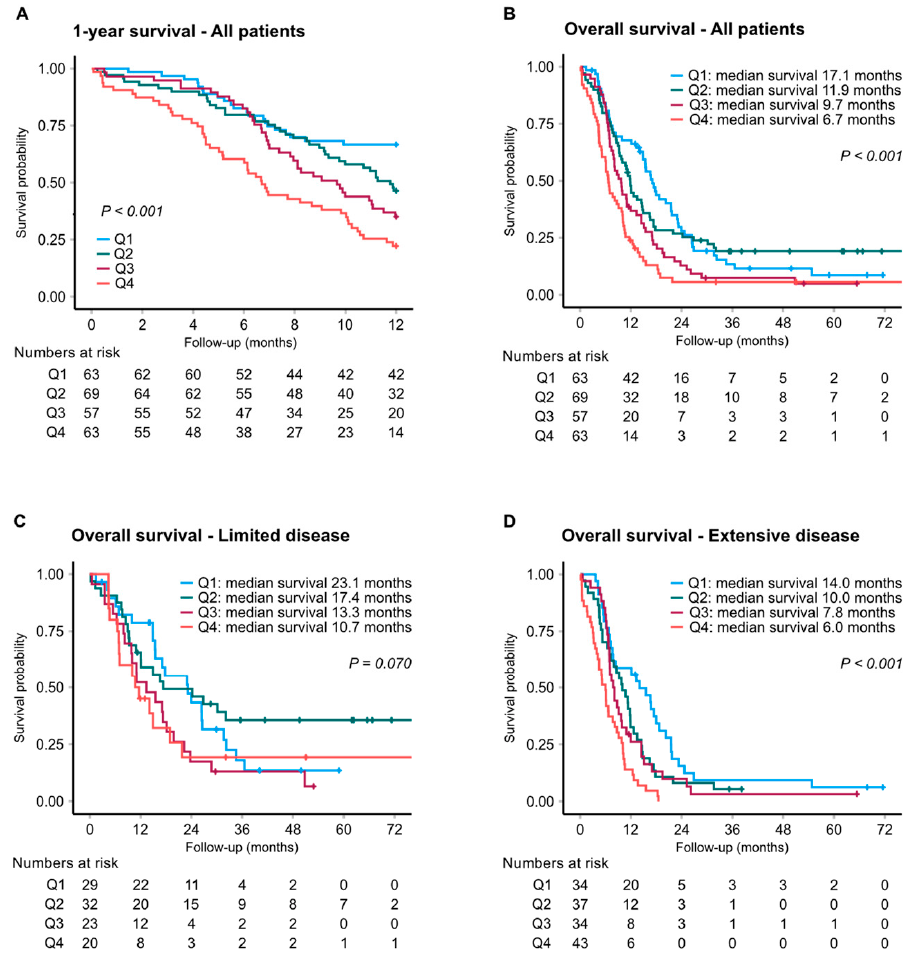
Figure 1. Kaplan–Meier analysis of survival by MR-proADM levels. One-year survival ( A ) and overall survival for all patients ( B ) and by stage; limited ( C ) and extensive ( D ) disease.